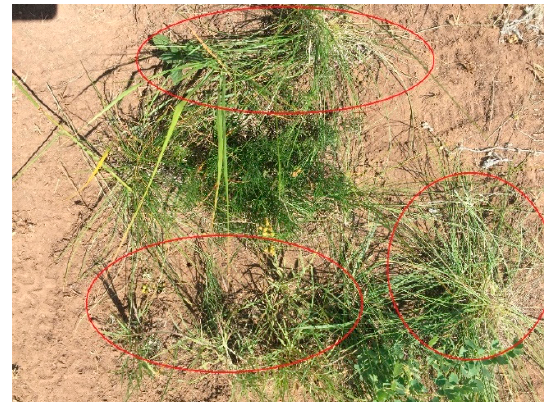
Figure 10. Photo of Stipa capillata from Baiyinkulun Grassland.